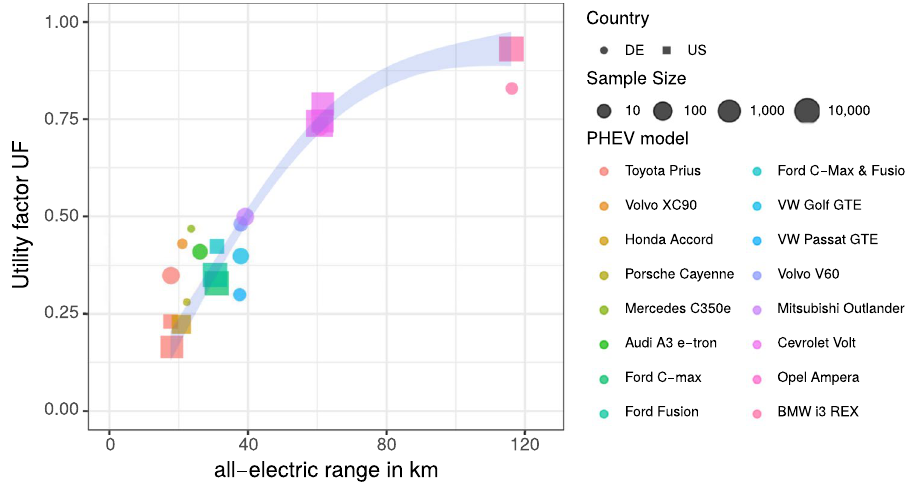
Figure 1. Real-world utility factors of PHEV in the US (squares) and Germany (circles) with different AER. Shown are mean values per PHEV model sorted by increasing AER with the symbol size indicating the size of the sample as well as a sample size weighted local regression (shaded area). We use EPA AER for US models and 75% NEDC AER for German models.